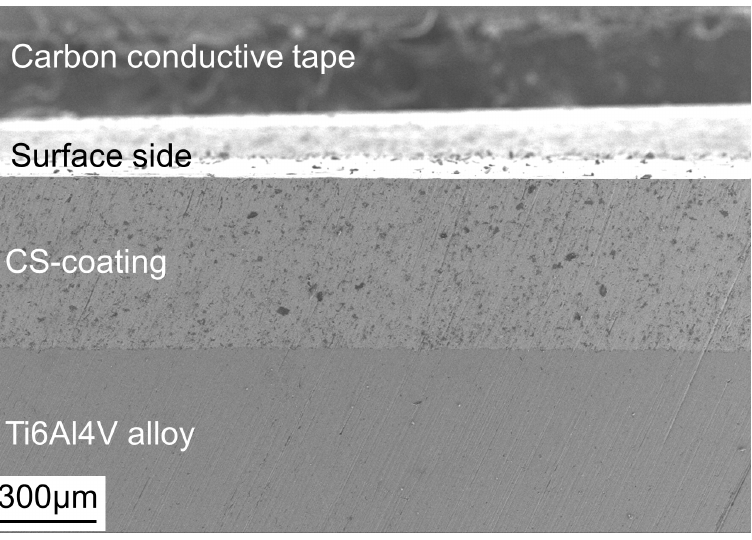
Figure 1. Cross-sectional morphology of Ti6Al4V alloy with CS-coating.